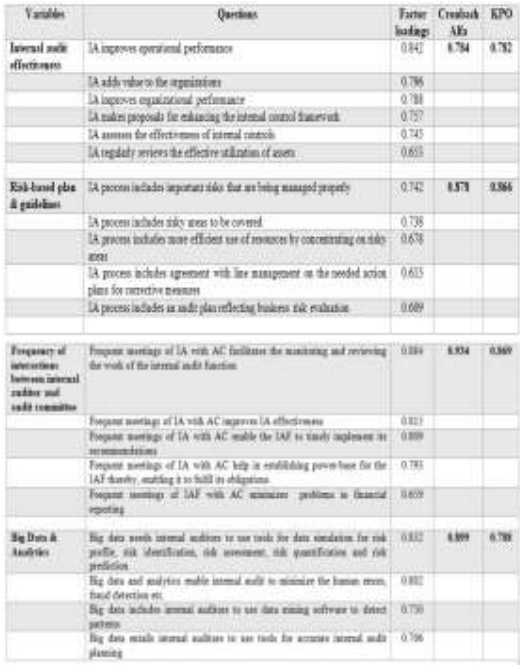
Table 1: Results of Factor Loading, Kaiser-Meyer- Olkin (KMO) and Reliability